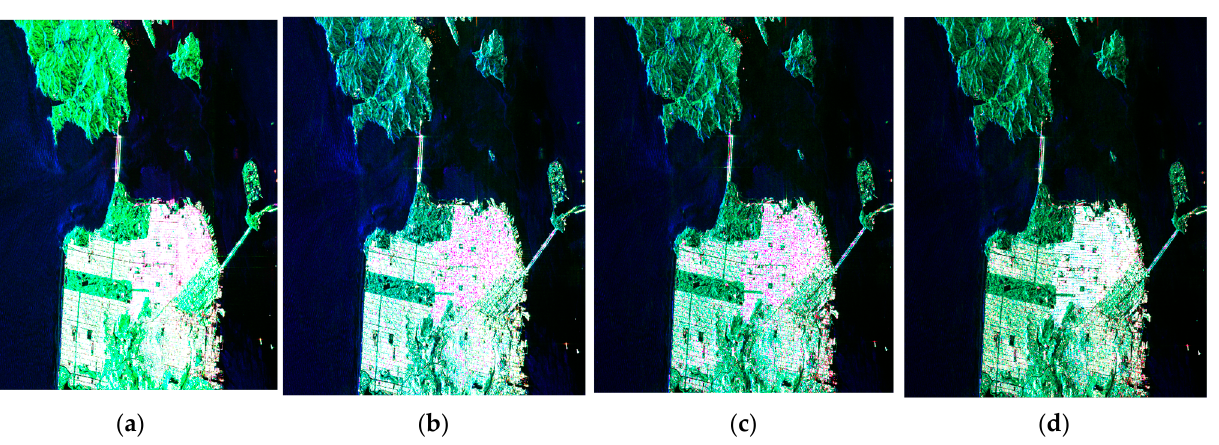
Figure 7. Pseudo-color image of quad-pol data and reconstruction results. ( a ) Quad-pol mode. ( b ) Souyris’ model. ( c ) Nord’s model. ( d ) proposed model.